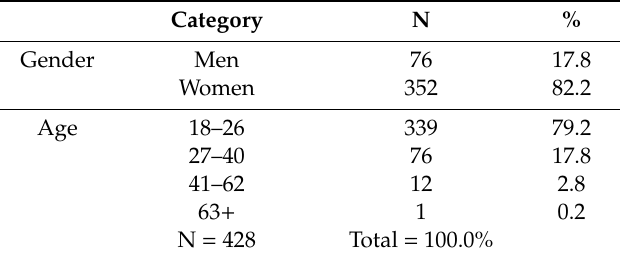
Table 1. Respondents’ demographic